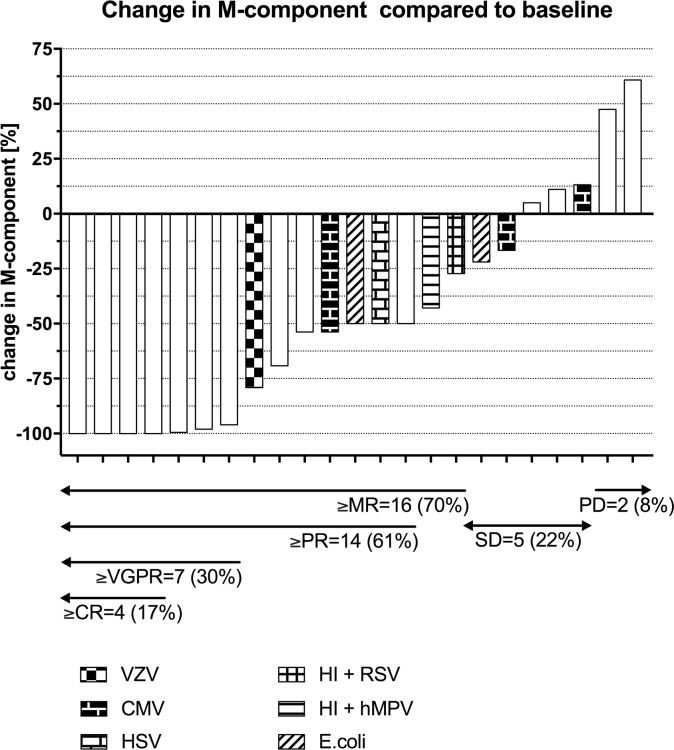
Waterfall plot of changes of M-component in response to dara treatment.The changes in measurable M-component are plotted and grouped according to IMWG treatment response criteria into CR = complete remission, VGPR = very good partial remission, PR = partial remission, MR = minimal response, SD = stable disease and PD = progressive disease. Bacterial and viral infections are shown for nine patients that suffered from infectious complications. VZV = varicella zoster virus, UTI = urinary tract infection, EBV = Epstein-Barr virus, HI = H. Influenza, hMPV = human metapneumovirus, RSV = respiratory syncytial virus, CMV = cytomegalovirus.